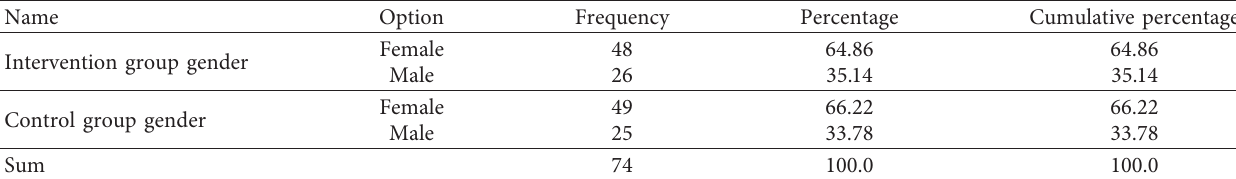
Table 3: Frequency analysis.